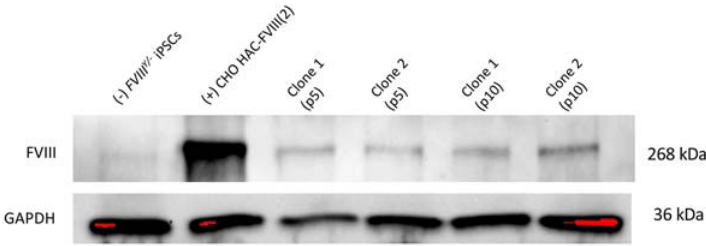
arrow. Scale bar—10 μ m, color ‐ coded markers are indicated on the panels.